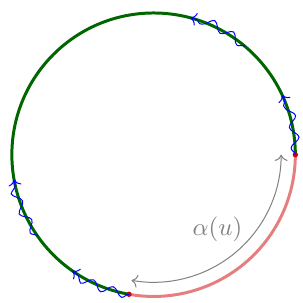
Figure 4 . A constant χ slice of the (renormalised) cylinder at I + of three-dimensional de Sitter in our partial reduction approach. In the two-dimensional picture the radiation ends up at I + (red), before evaporating into the bath (green), which is located along a higher dimension ( ϕ ). The transfer of radiation from dynamical gravity to bath corresponds to (3.17). Note that as u increases, α ( u ) will decrease such that we are indeed modelling an evaporating system. We included the higher-dimensional de Sitter region in opaque red to clarify the entanglement